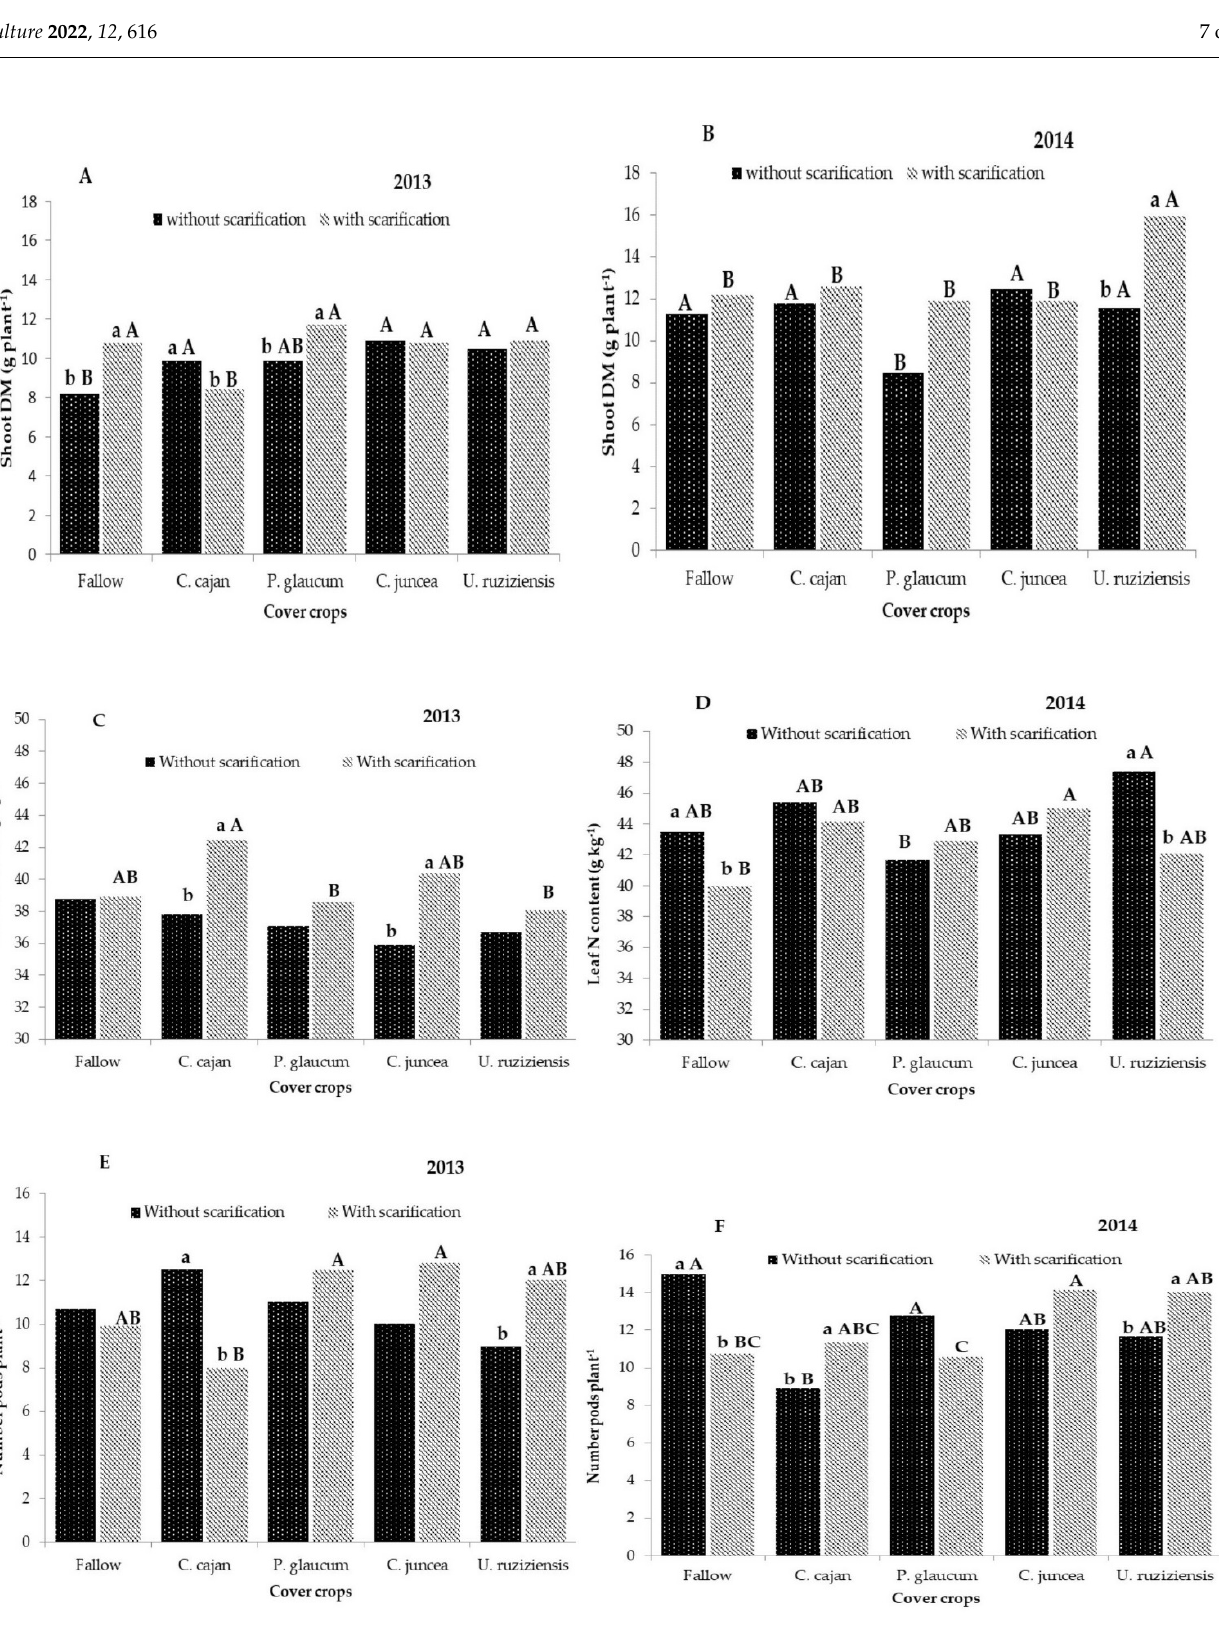
Figure 2. Interactions for shoot dry matter (DM- A , B ), leaf nitrogen (N) content ( C , D ) and number of pods per plant of “winter” common bean ( E , F )after mechanical soil chiseling (MSC) and predecessor cover crops (CC) in a no-tillage system. Averages followed by same lowercase letter for CC within MSC and capital for MSC within CC did not statistically differ by Tukey test at 5% significance in 2013 and 2014, respectively.